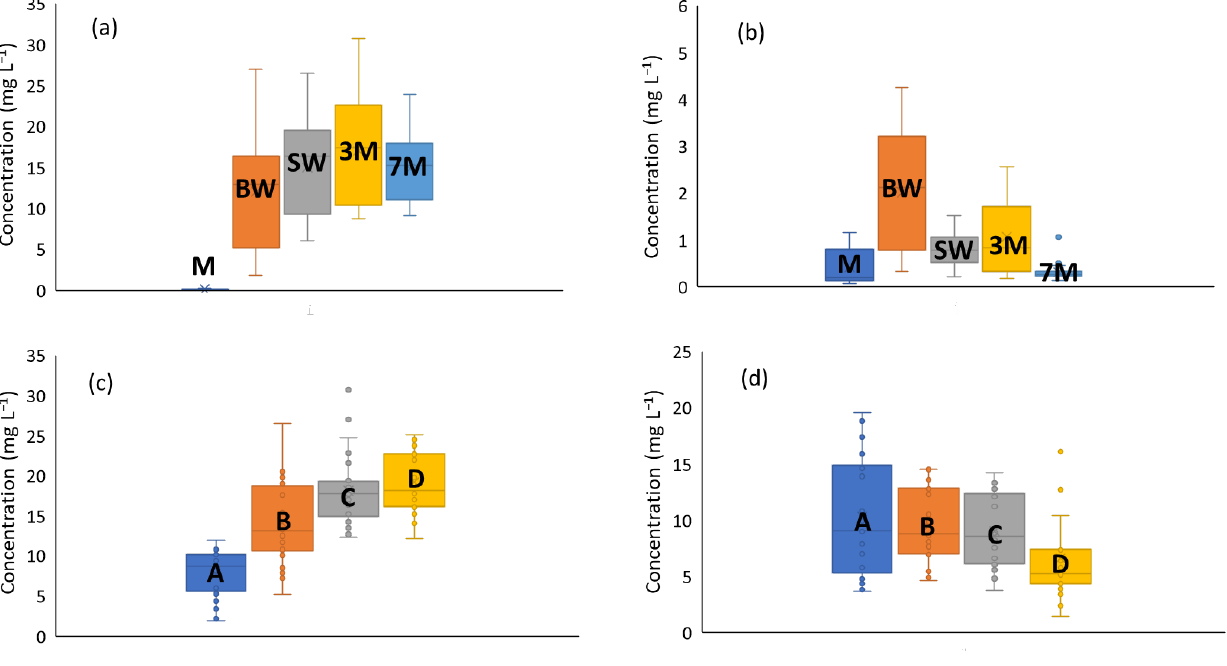
Figure 2. Box-plots displaying the distribution of the concentrations of representative compounds as a function of the quality or the oenological type. Assignation: ( a ) Glutamic acid levels for musts (M), base wines (BW), stabilized wines (SW), sparkling wines (3 months aged, 3M), and sparkling wines (7 months aged, 7M). ( b ) Glutamine levels for musts (M), base wines (BW), stabilized wines (SW), sparkling wines (3 months aged, 3M), and sparkling wines (7 months aged, 7M). ( c ) Glutamic acid levels for samples of quality A, B, C, and D. ( d ) Tyrosine levels for samples of quality A, B, C, and D.